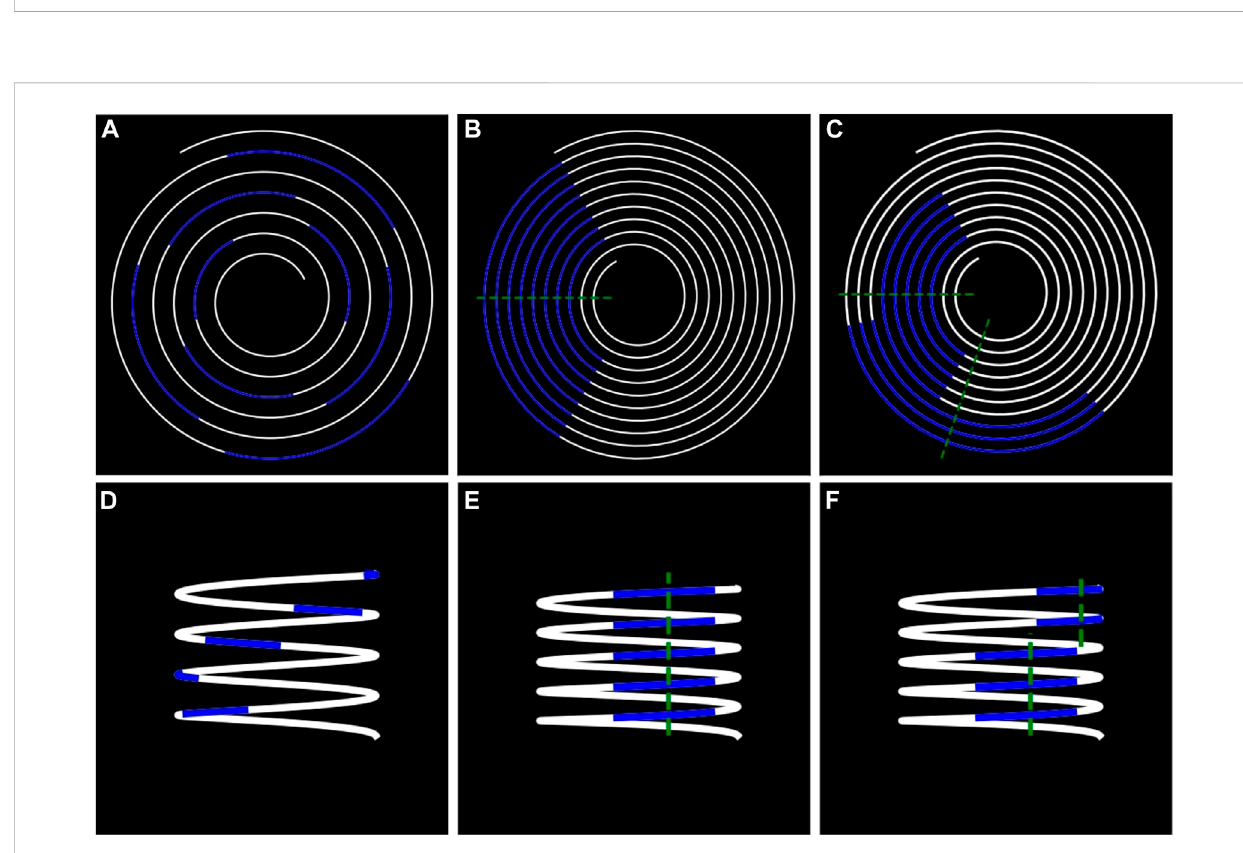
FIGURE 3 Comparison between spirals and helix. The same signal is represented in visualizations (A) and (B) . It is possible to make periodic patterns appear by changing the period of the spiral. The same principle happens in visualizations (D) and (E) when changing the period of the helix. On visualization (B) and (E) , all the points of the spiral (or the helix) that cross the green line are spaced by the same period of time. On visualization (C, F) , a break in the periodic pattern appears, the distances between the two green lines represent a phase